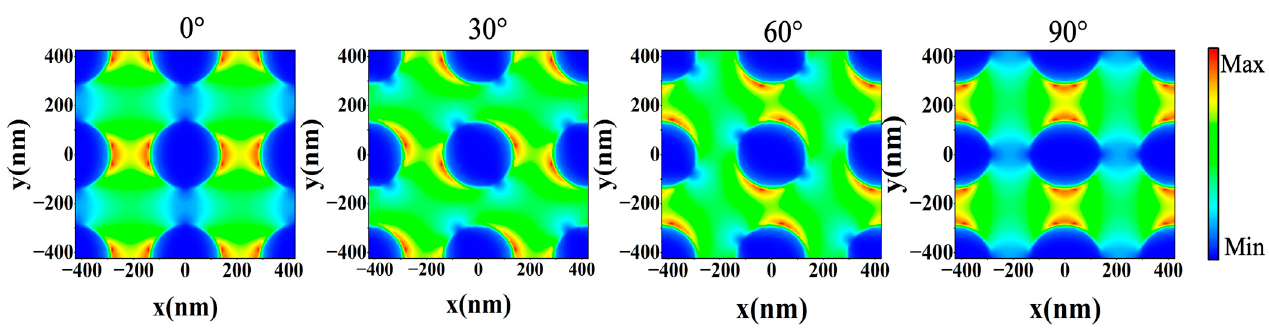
Figure 9. Simulated electric field distribution of the meta-structure absorber at 500 nm with polarization angles of 0°, 30°, 60° and 90°.